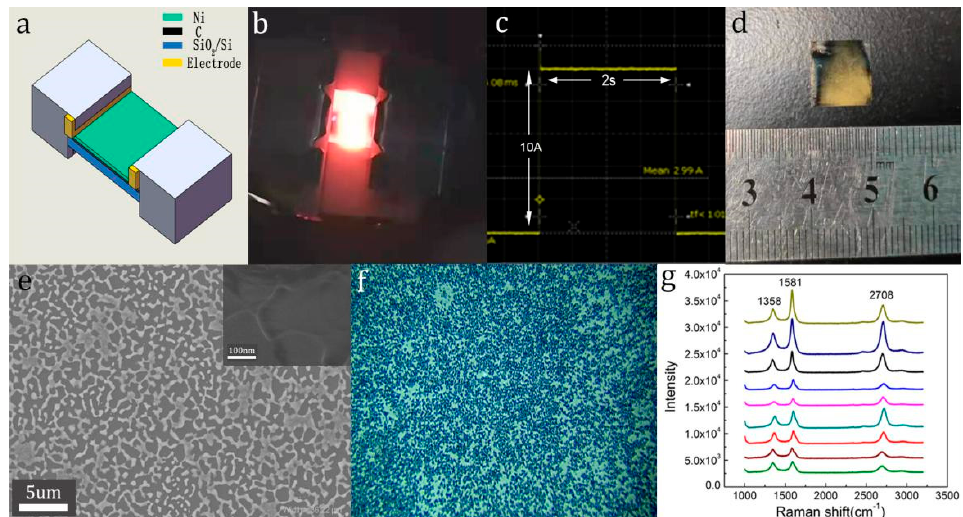
Figure 1. ( a ) Schematic diagram of experimental set-up for the growth of graphene film on the surface of Si wafer by ultrafast quenching method using pulse current; ( b ) photograph of Si wafer after a current flow through Cu electrode; ( c ) a single pulse of a current of 10 A with a pulse width of 2 s, recorded by an oscilloscope; ( d ) photograph of graphene thin film on the surface of Si wafer; ( e ) high-resolution SEM(HR-SEM) image of the graphene, the wrinkles of graphene film are clearly visible in the illustration; ( f ) Raman optical diagram of graphene thin film in Figure 1d; ( g ) Raman spectra recorded at different positions showed the fully covered graphene film.